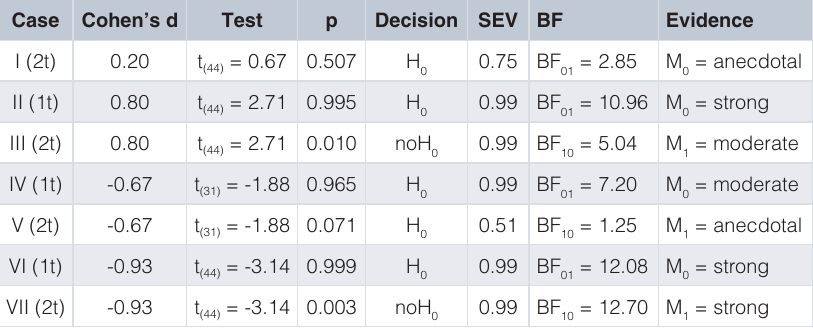
Table 1. Reasonable conclusions based on frequentist and Bayesian